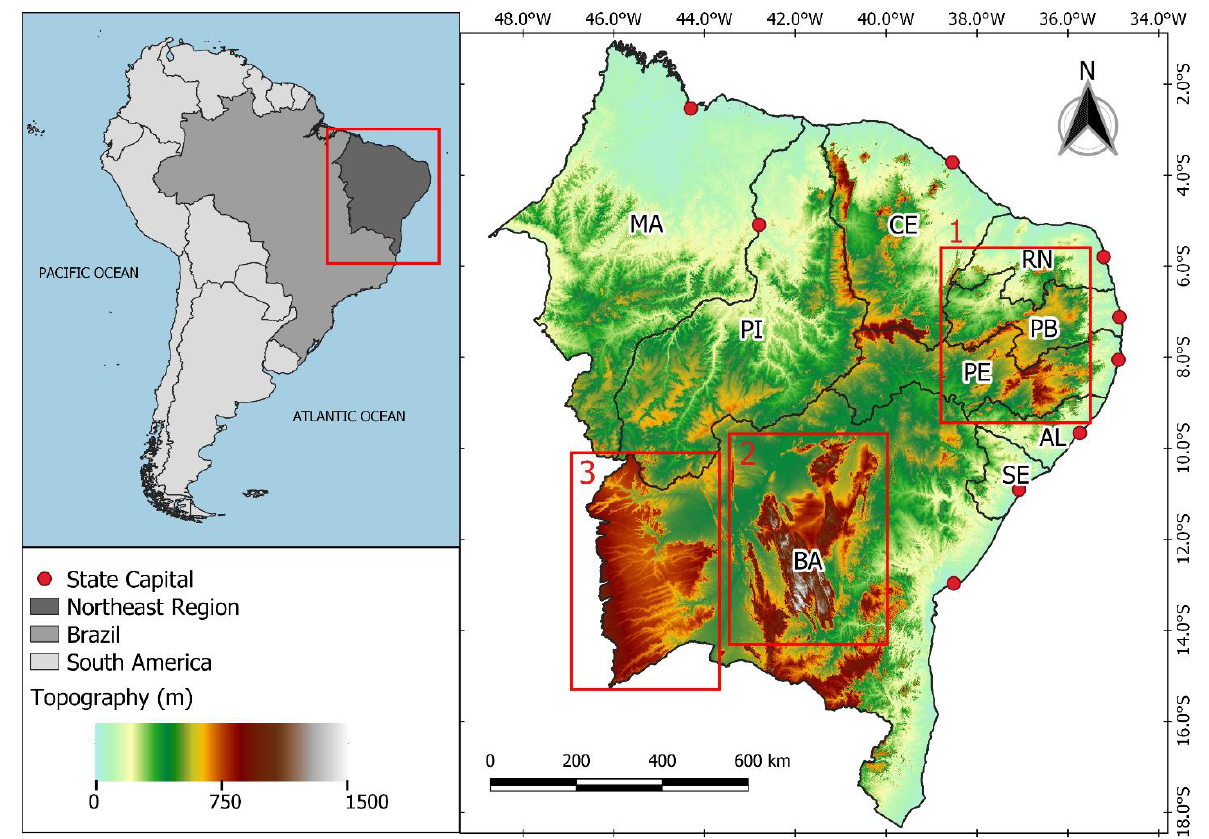
Figure 1. Geographical location of NEB and topography (m) with state division. The red circles represent the location of the state capitals. The boxes denote the main topographic formations: (1) Borborema Plateau; (2) Chapada (high plains) Diamantina; and (3) Chapada das Mangabeiras and Serra [mountain range] Geral do Goiás.